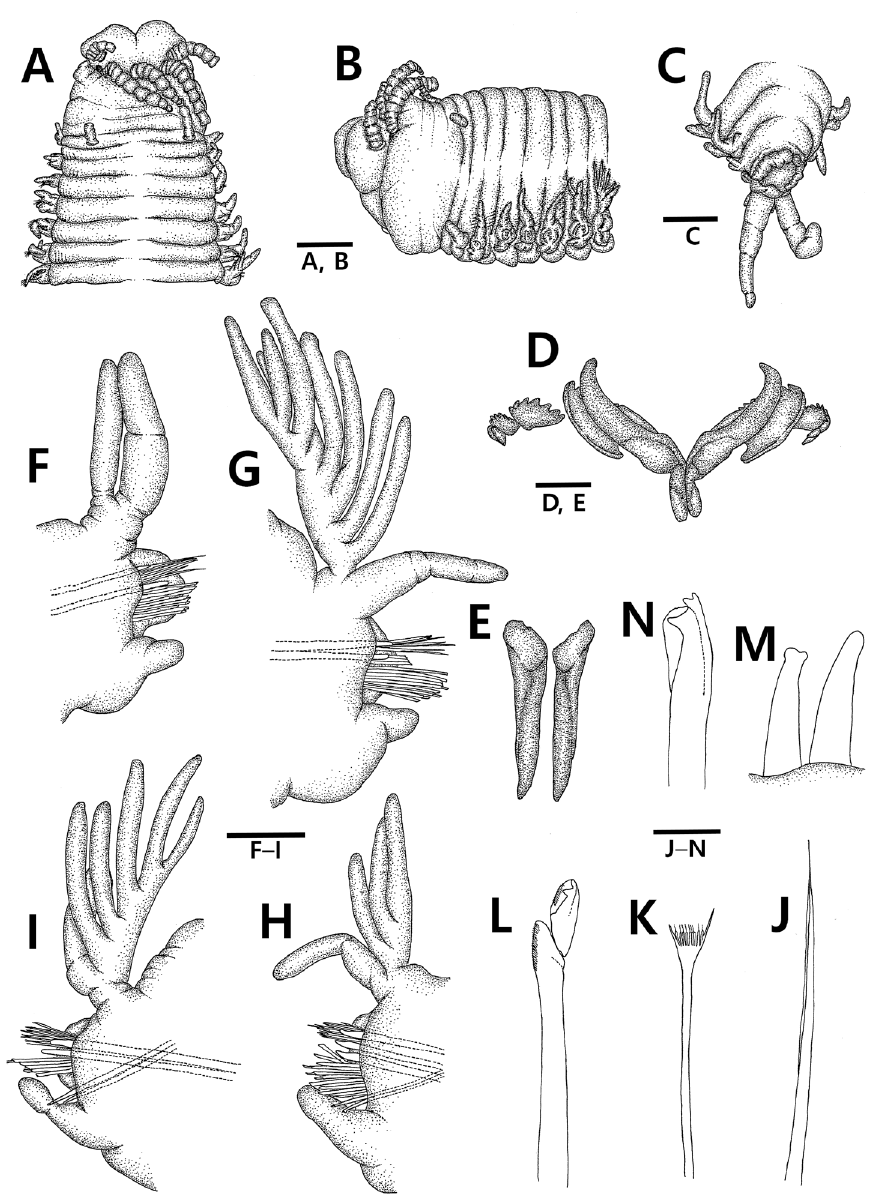
Figure 1. Leodice duplexa sp. n., A–C, F–N holotype (MABIKNA00146045) D, F paratype (MABIKNA00146046) A anterior end, dorsal view B anterior end, lateral view C posterior end, dorsal view D maxillae E mandible F left parapodium VI, anterior view G left parapodium XX, anterior view H right parapodium XXXVIII, anterior view I right parapodium LX, anterior view J limbate chaeta on parapodium XLVII K pectinate chaeta on parapodium XLVII L compound falciger on parapodium XLVII M subacicular hook on parapodium XXXVIII N aciculae with blunt and hammer-headed tips on parapodium LXXXV. Scale bars: 1.0 mm ( A, B ), 0.5 mm ( C–E ), 0.4 mm ( F–I ), 0.05 mm ( J–N